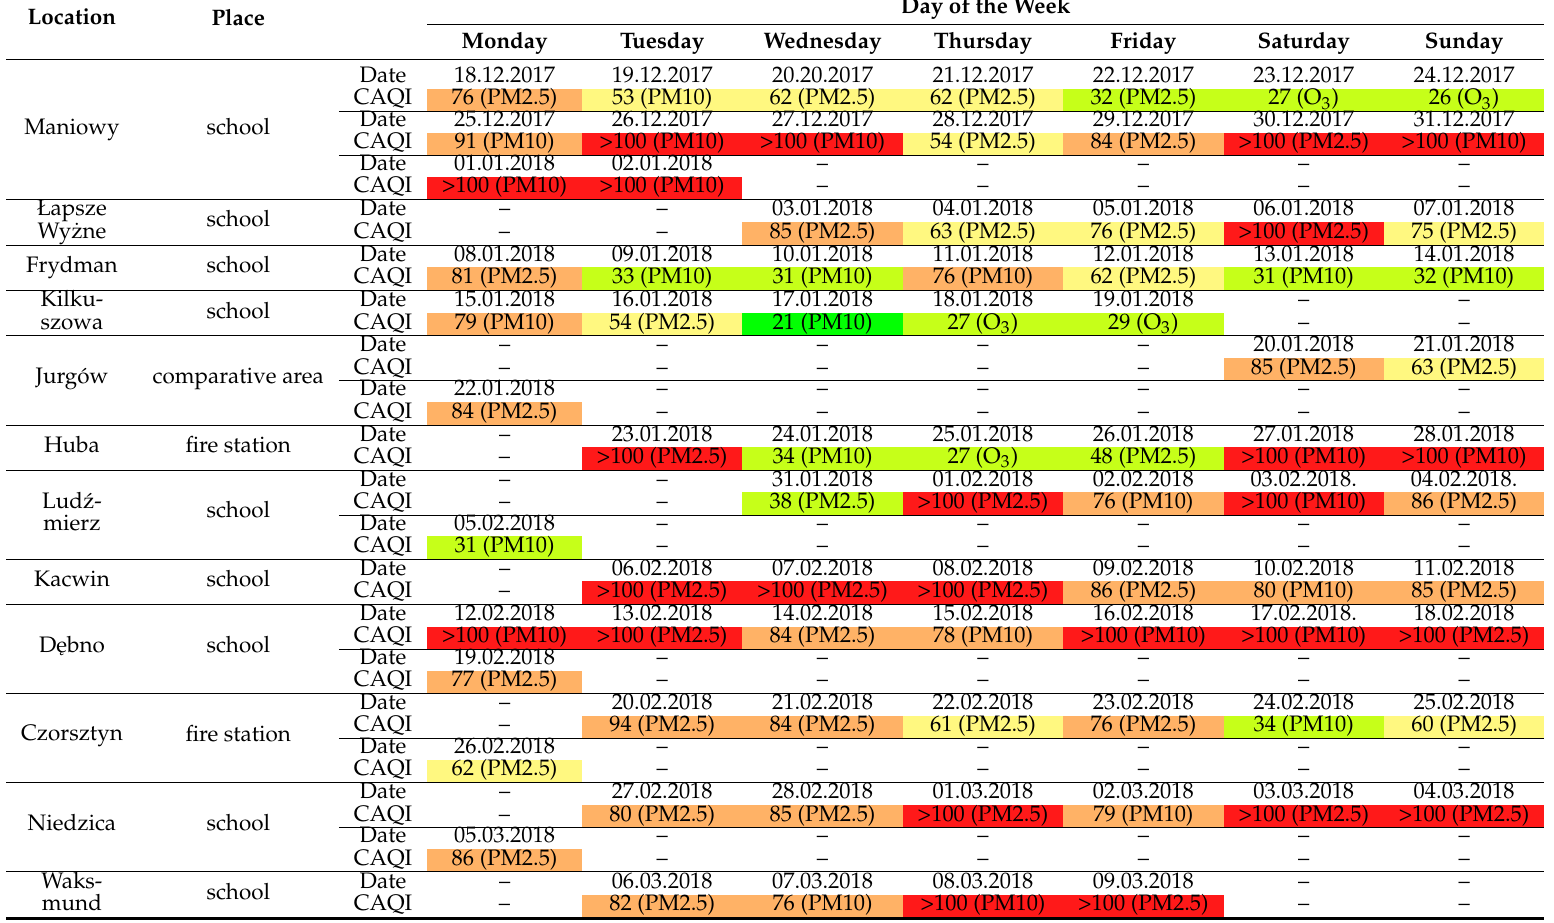
Table 4. Values of calculated European CAQI index of air quality in the analysed region of Niedzica, where “–” means not applicable.